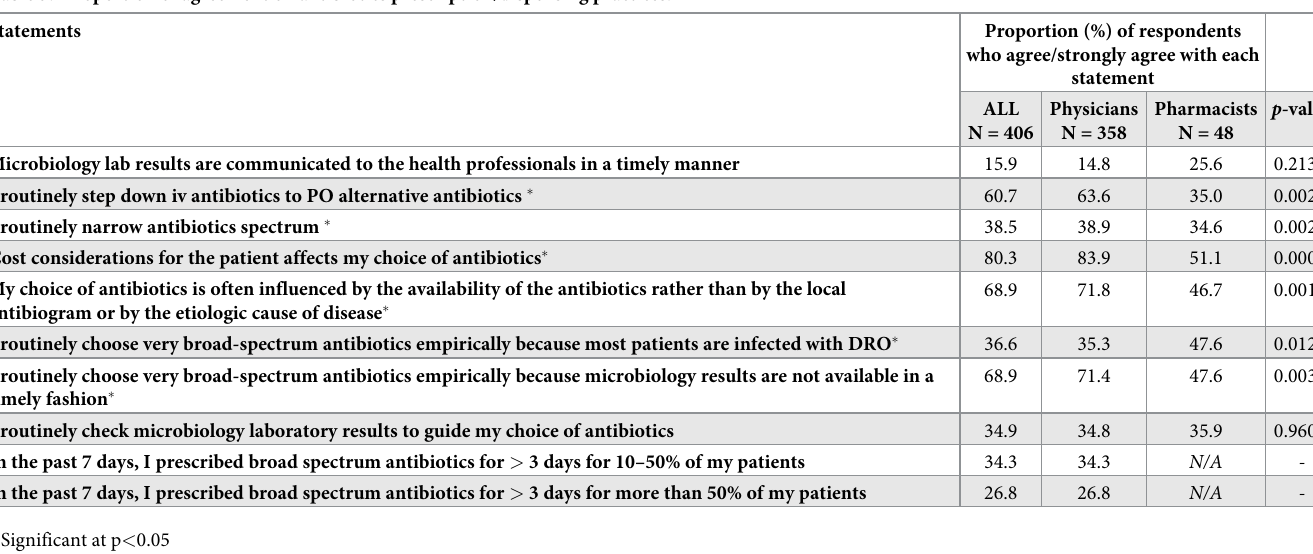
Table 3. Proportion of agreement on antibiotics prescription/dispensing practices.